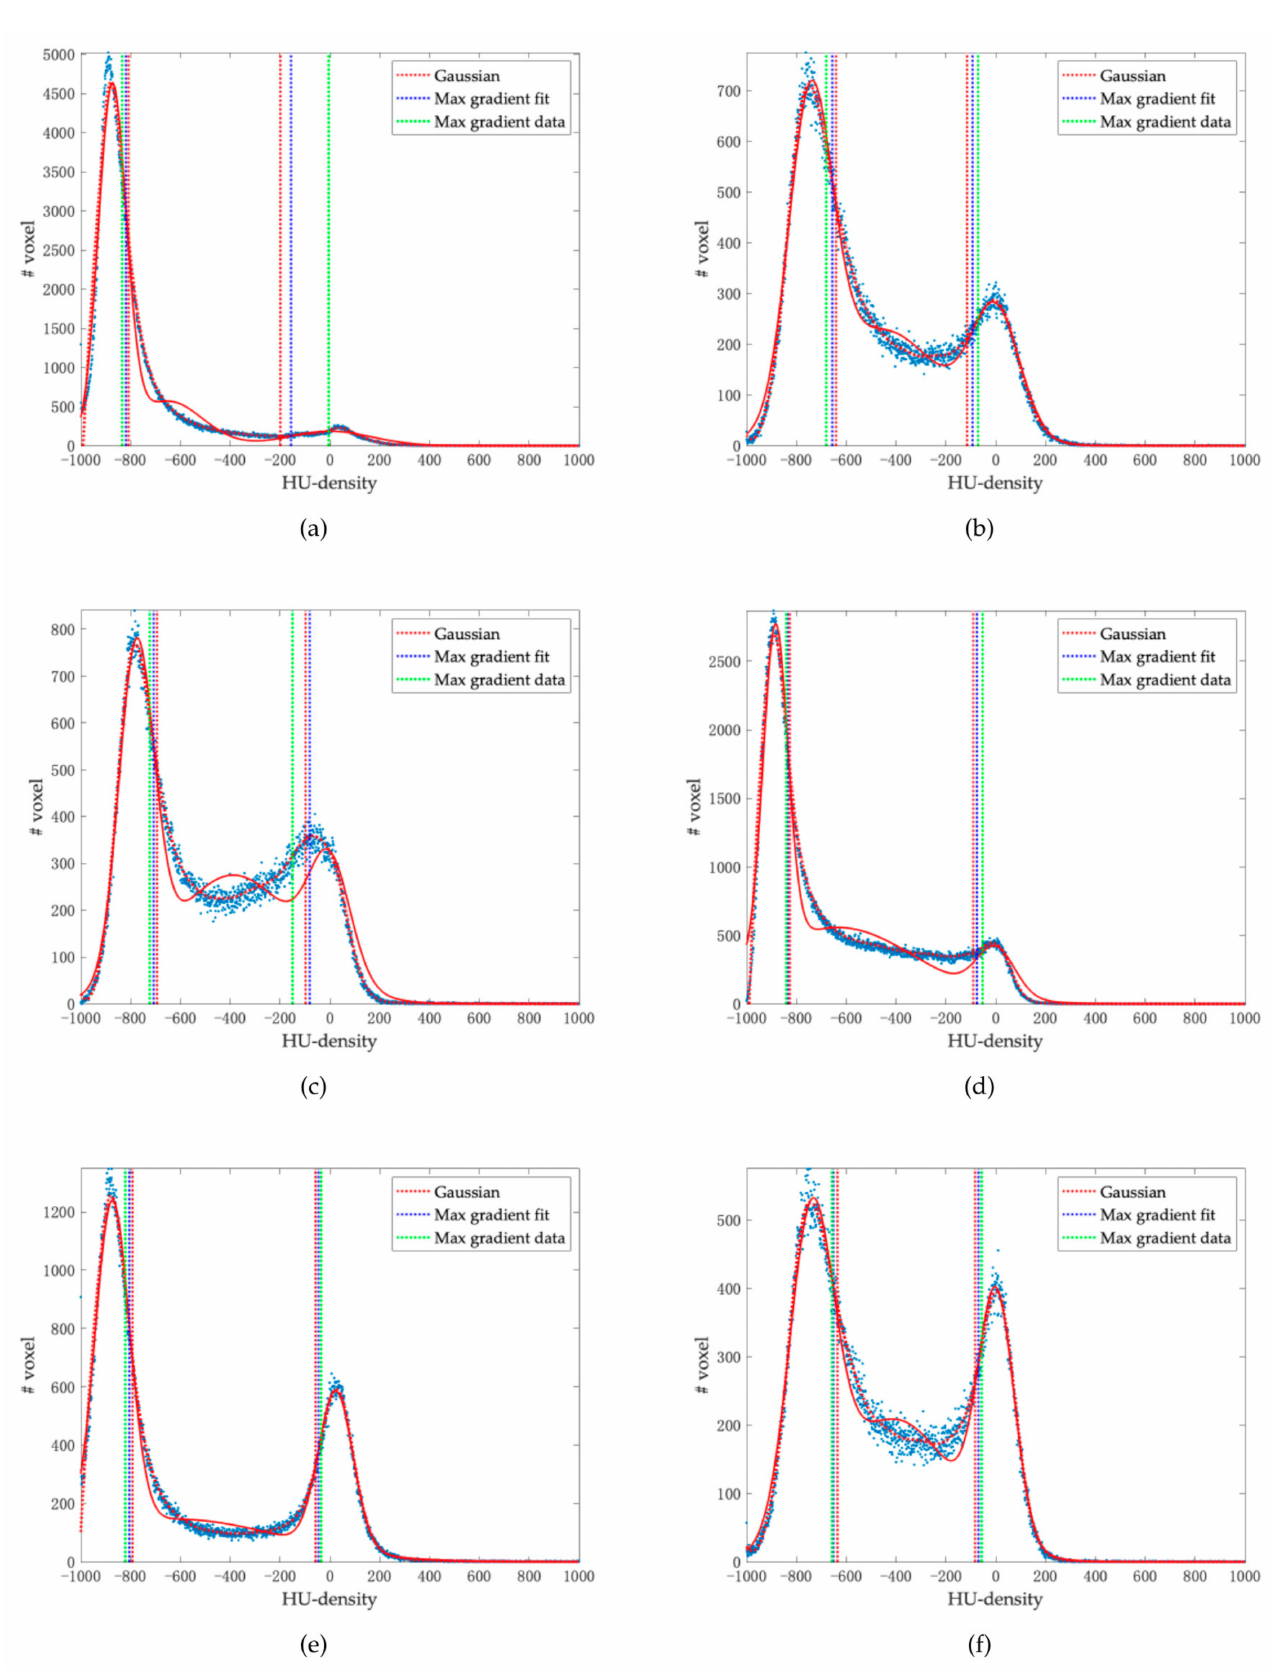
Figure 5. ( a – f ) Examples of graphical representation of the threshold values found by analyzing the HU-density histograms with the methods